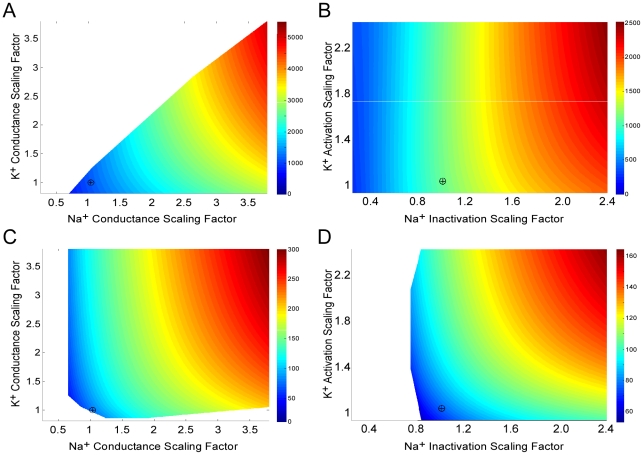
Scaling biophysical properties of voltage-gated ion channels influences action potential energy consumption.(A) Scaling the conductance per unit area of Na+ (gNa) and K+ (gK) channels affects the Na+ load of the action potential of the squid giant axon (SA) model. (B) Scaling the inactivation (τh) time constant of the Na+ voltage-gated channel and the activation (τn) time constant of the K+ voltage-gated channel affects the Na+ load of the action potential of the squid giant axon (SA) model. (C) Scaling the conductance per unit area of Na+ (gNa) and K+ (gK) channels affects the Na+ load of the action potential of the rat hippocampal interneuron (RHI) model. (D) Scaling the inactivation (τh) time constant of the Na+ voltage-gated channel and the activation (τn) time constant of the K+ voltage-gated channel affects the Na+ load of the action potential of the rat hippocampal interneuron (RHI) model. Colors indicate the Na+ load of a single AP (nC cm−2). ‘+’ indicates the Na+ load of the original model.